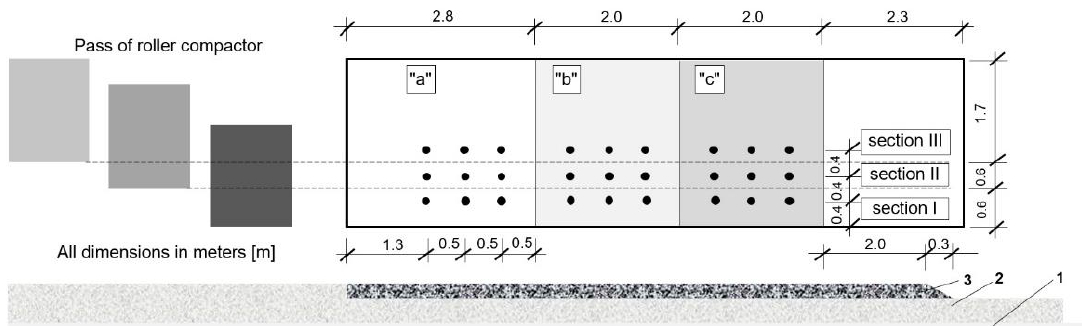
Figure 3. Schematic representation of the test section showing the effect of the number of roller passes and the content of moisture in the underlying layer on the relative compaction of the asphalt